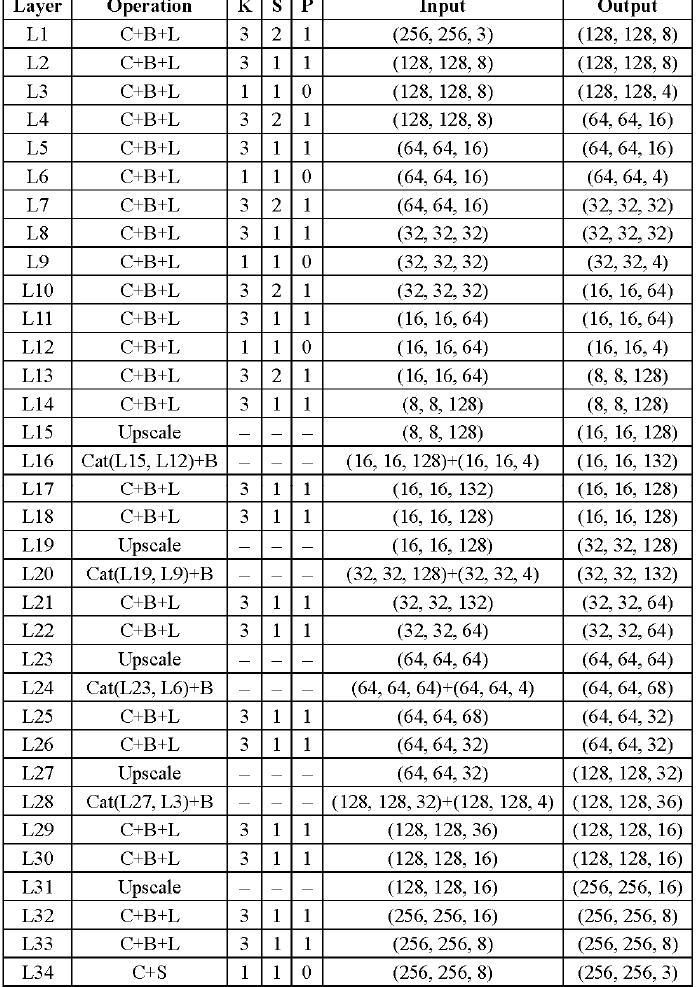
Figure 4. A detailed configuration of the J-Net. ‘C’ denotes the convolution layer. ‘B’ denotes batch normalization. ‘L’ denotes Leaky ReLU activation. ‘Upscale’ denotes bilinear upscale layer. ‘S’ denotes Sigmoid activation. ‘Cat’ denotes concatenate operation as the skip connection. ‘K’ denotes the kernel size. ‘S’ denotes the stride size. ‘P’ denotes the padding size. ‘Input’ denotes the input image size ( h × w × c ). ‘Output’ denotes the output image size ( h × w × c